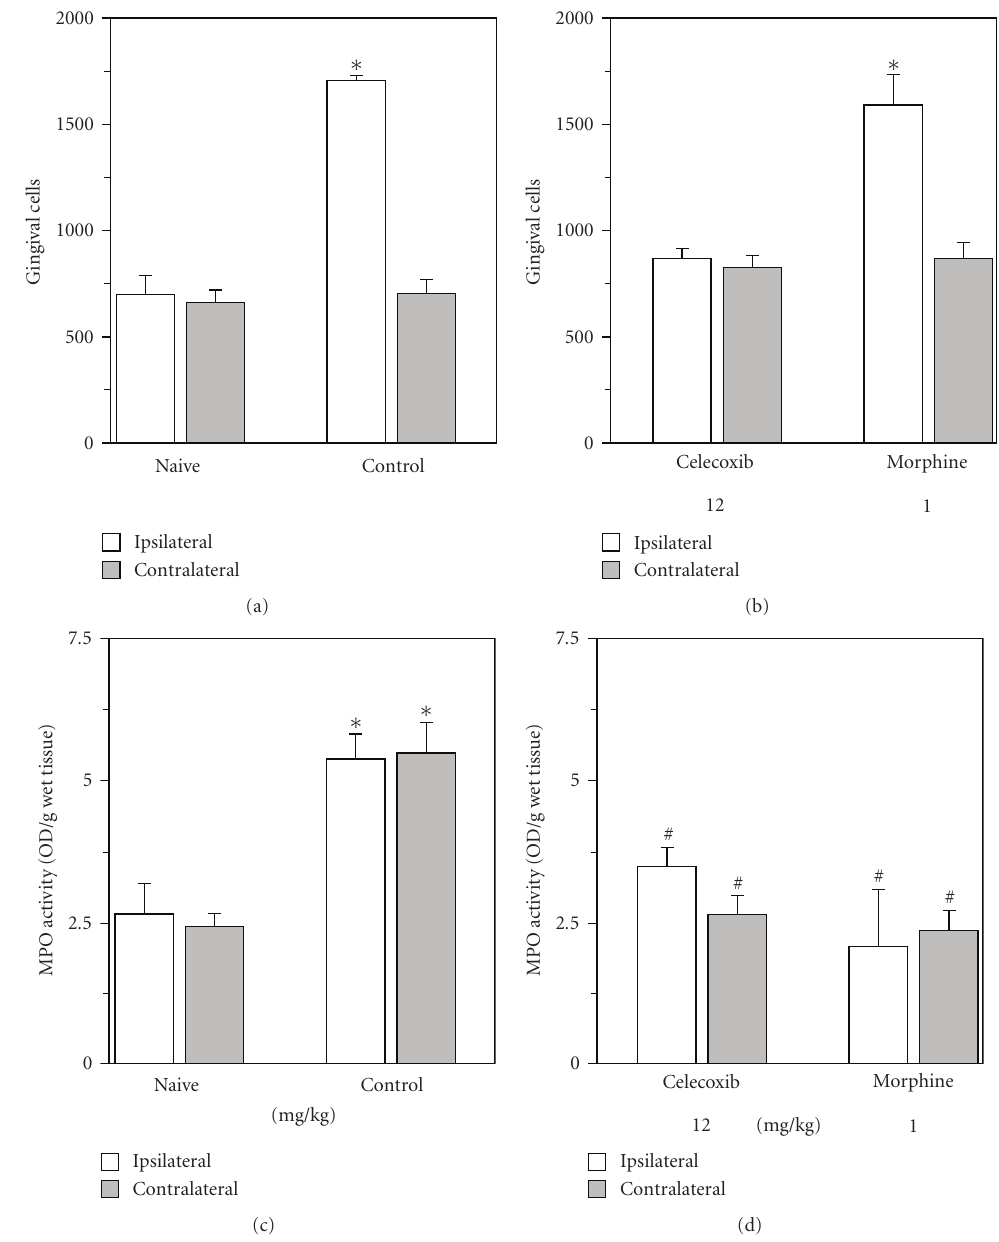
Figure 3: Leukocyte recruitment and myeloperoxidase activity in gingivomucosal tissue surrounding rat molar tooth from naive, nontreated and periodontal-diseased treated rats. Either celecoxib (12mg/kg/day) or morphine (1mg/kg/day) was administered subcutaneously (0.1mL per 100g body weight) once a day, for 3 consecutive days, from 3rd to 5th day after ligation. Animals were killed on the 11th day of ligation. Sterile physiological saline was given in the same volume and route of administration in control animals. Naive (N) animals were left nonligated. Gingivomucosal tissue samples of ligated (ipsilateral) and non-ligated (contralateral) second molar tooth ( ∼ 20mm 2 ) were removed from naive, and drug-treated rats and were prepared for histological analysis (Panels (a) and (b)) and MPO activity (Panels (c) and (d)) as described in Materials and Methods. In panels (a) and (b) ∗ indicates a significant di ff erence ( P < .05) from contralateral side and in panels (c) and (d) ∗ and # indicate significant di ff erence ( P < .05) in relation to naive and control group, respectively; using one-way ANOVA followed by Student-Newman-Keuls test; 4–6 animals per